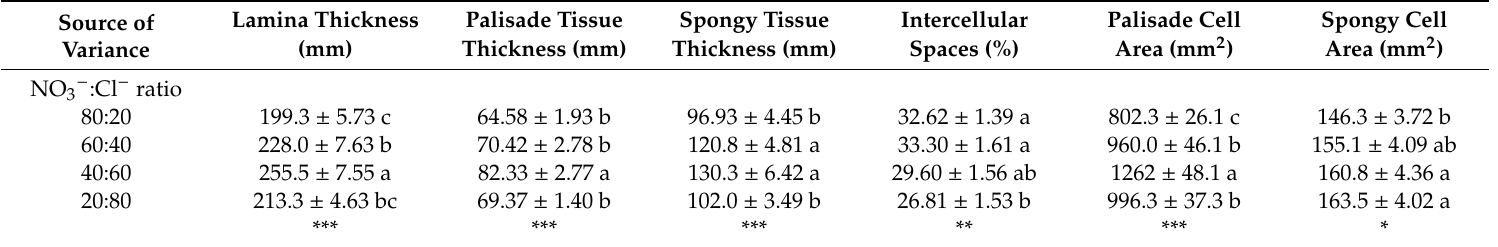
Asterisks indicate a statistically significant di ff erence (***: p < 0.001; **: p < 0.01; *: p < 0.05; ns: non-significant, p ≥ 0.05). For each source of variance, di ff erent letters within each column indicate statistically di ff erent groups according to the Duncan’s post-hoc test ( p = 0.05). The factor “Cut” was analyzed using an independent Student’s t-test. Data are mean values ± standard error, n =